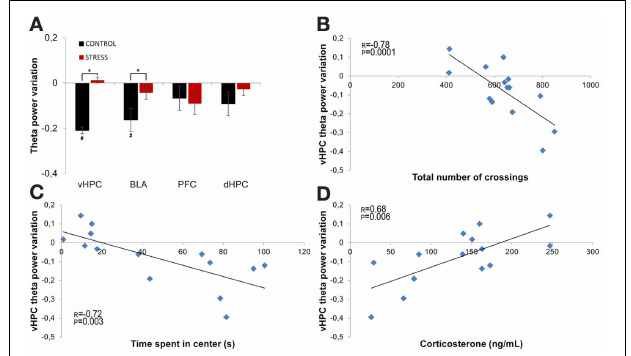
FIGURE 5 | Theta power variation between first and last exposures to the OF arena. (A) Theta power variation between the initial exposure (unfamiliar environment, day 1, origin) and the final exposure (familiar environment, day 21) to the OF arena from activity recorded from ventral hippocampus (vHPC), basolateral amygdala (BLA), dorsal hippocampus (dHPC), and medial prefrontal cortex (PFC). Control rats significantly reduced theta power in vHPC and BLA through familiarization between the first and last exposure to the OF arena while stressed rats failed to display a similar reduction. (B) Correlation of vHPC theta power variation between first and last exposures to the OF arena and exploratory activity, as measured by the total number of crossings between the squares on which the arena was divided for behavioral analysis, on the last exposure to the OF arena. (C) Correlation of vHPC theta power variation between first and last exposures to the OF arena and time spent in the center on the last exposure to the OF arena. Rats that presented the biggest reduction of vHPC theta power between the first and last exposure to the OF arena were the same that presented higher exploratory activity and spent more time in the center on the last exposure to the arena. (D) Correlation of vHPC theta power variation between first and last exposures to the OF arena and serum corticosterone measured on the day following the last exposure to the arena. Rats that presented the lowest levels of serum corticosterone on the day following the last exposure to the OF arena were also the same that presented the highest reduction of vHPC theta power between the first and last exposure to the OF arena. # p < 0 . 05 for paired Wilcoxon sign rank test comparison of within group theta power estimates between exposures; ∗ p < 0 . 05 for unpaired Wilcoxon rank sum test comparison of average theta power variation between groups on each exposure. Error bars: ± s.e.m. Plotted r and p values for correlations are for Pearson correlation.